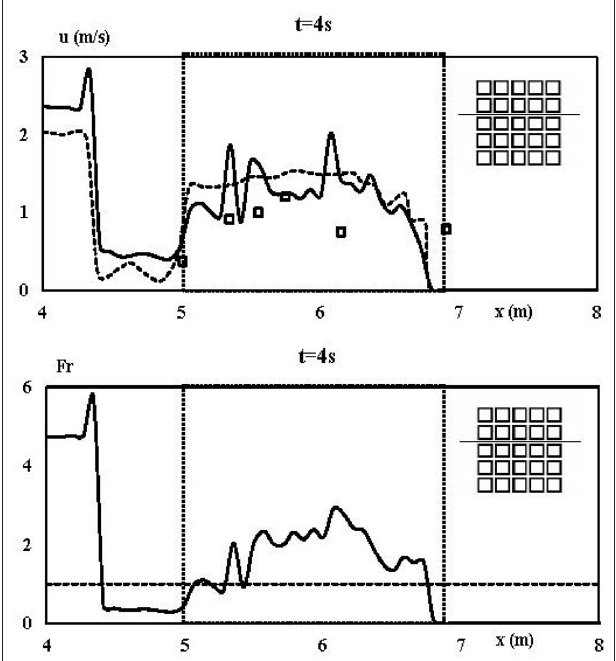
FIGURE 7 | Test case III. Experimental dam break flow through an idealized city of Soares-Frazão and Zech (2008). Bottom : Froude number profile at 4 s along the third longitudinal street, as indicated by the sketch. Solid line: DBE numerical results. Dotted box: area occupied by the buildings. Top : u velocity profile at 4 s along the third longitudinal street, as indicated by the sketch. Solid line: DBE numerical results. Dashed line: shallow water numerical results of Soares-Frazão and Zech (2008). Dots: experimental results of Soares-Frazão and Zech